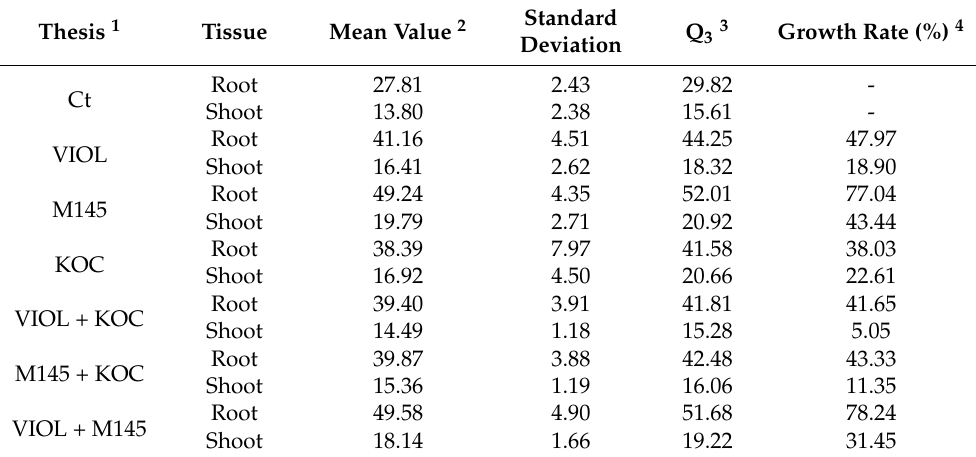
Table 3. Effect on the root and shoot of S. lycopersicum seedlings due to PGP actinobacteria treatments on seeds.